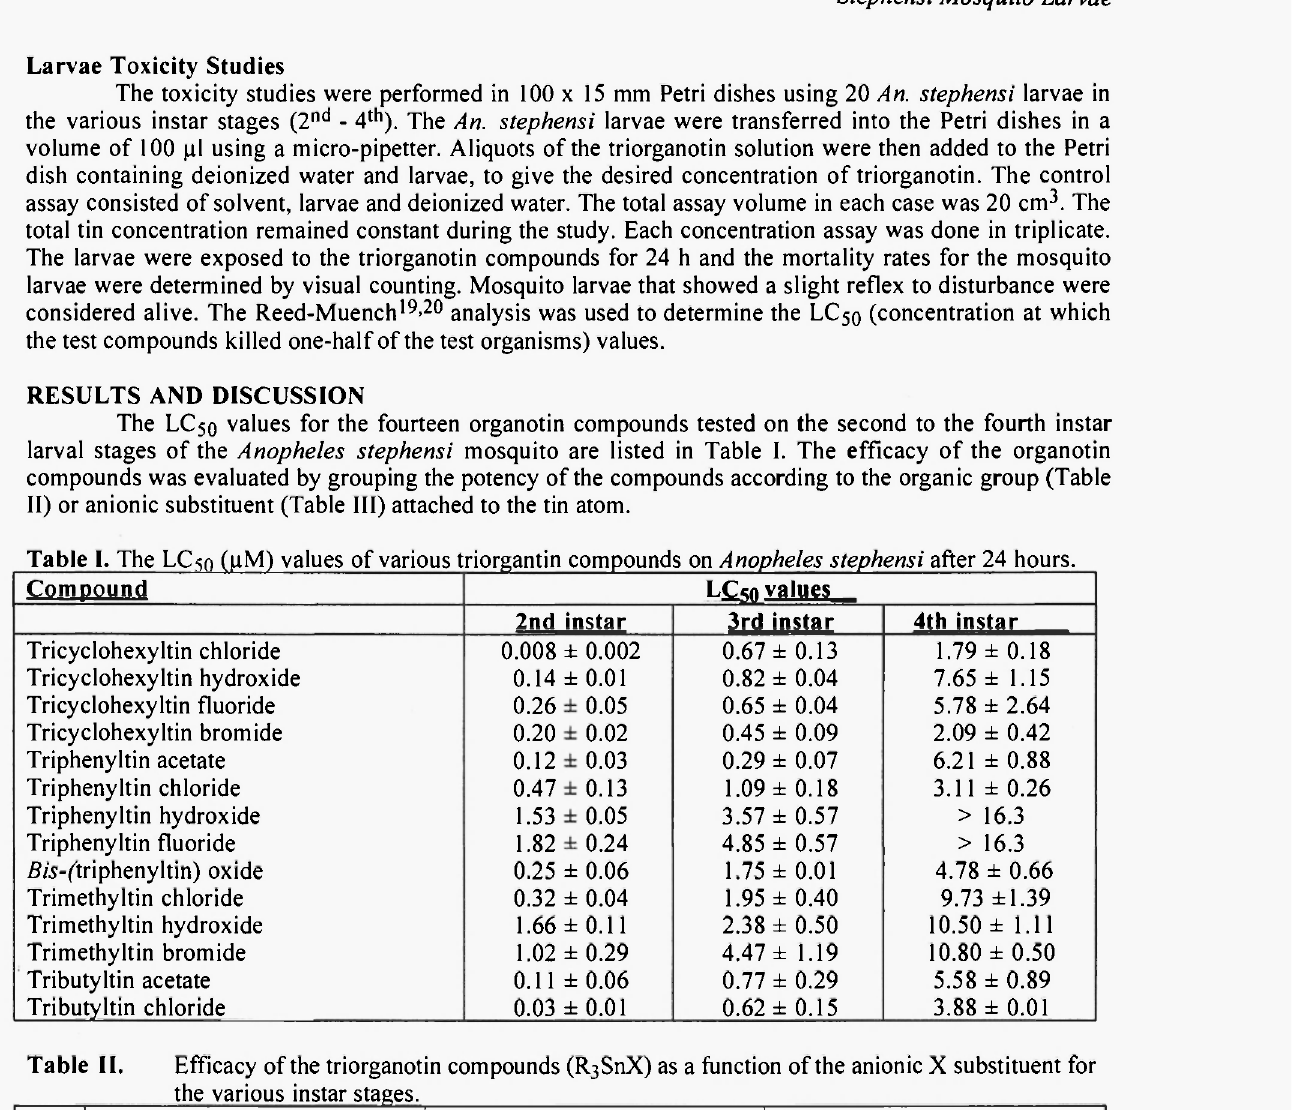
Table II. Efficacy of the triorganotin compounds (R3SnX) as a function of the anionic X substituent for the various instar